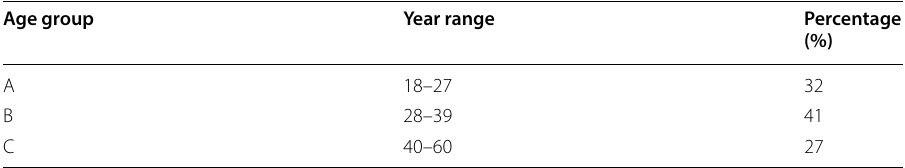
Table 4 Demographics data for